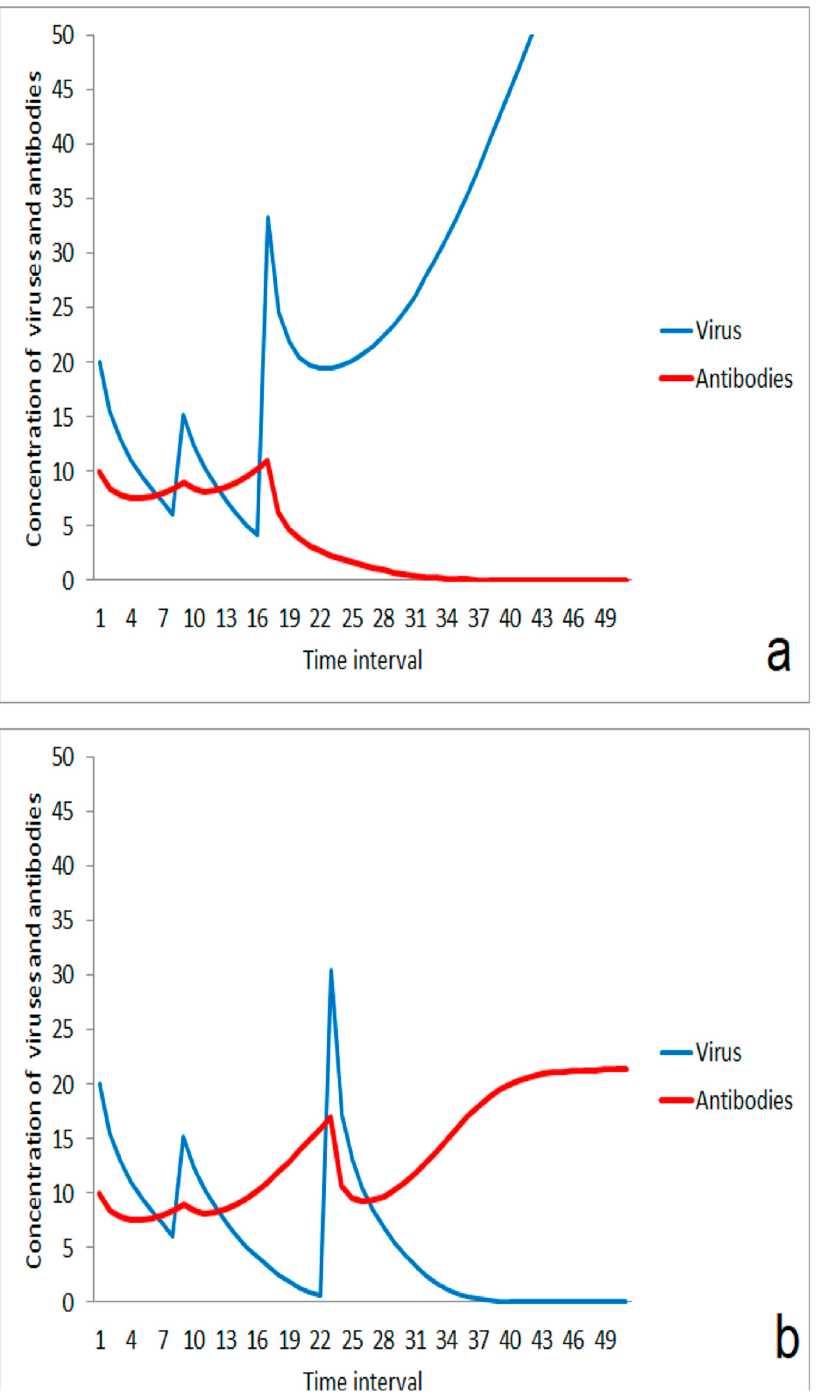
Figure 6. Role of the duration between a second and a third virus impact in case of a two-step immunization on immune response: ( a ) outbreak of disease after a short time span; ( b ) suppression of infection after a longer duration between last virus impacts.